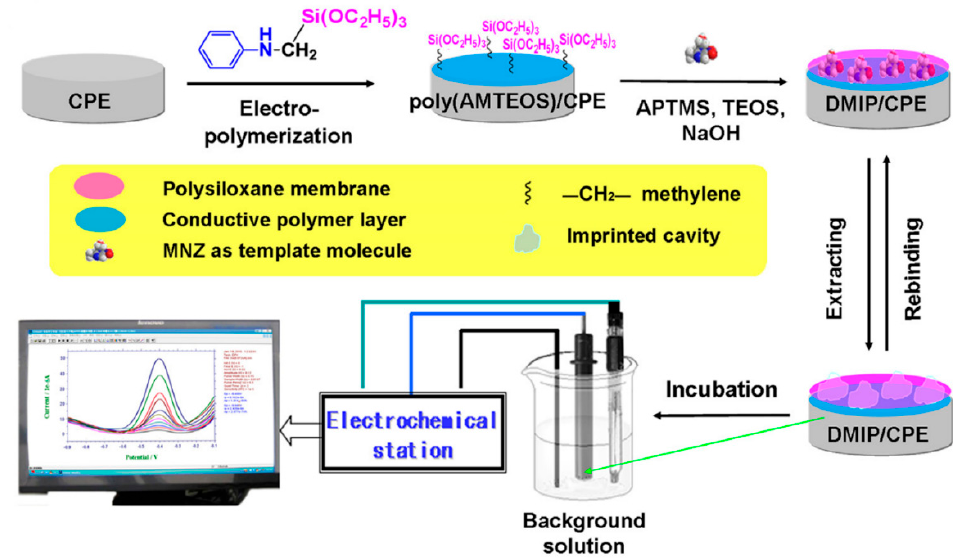
Figure 16. Schematic illustration for the preparation of duplex molecularly imprinted polymer/carbon paste electrodes (DMIP/CPE). Modified with permission from [207]. Copyright 2016 Elsevier.